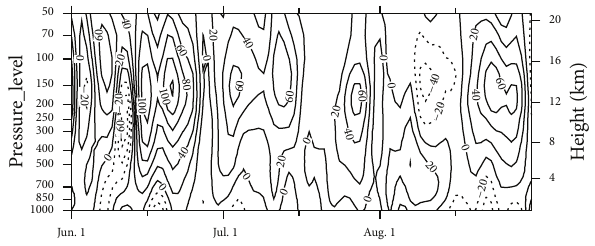
Figure 6: The time-height section of geopotential height anomaly averaged in the region A in the summer of 2013